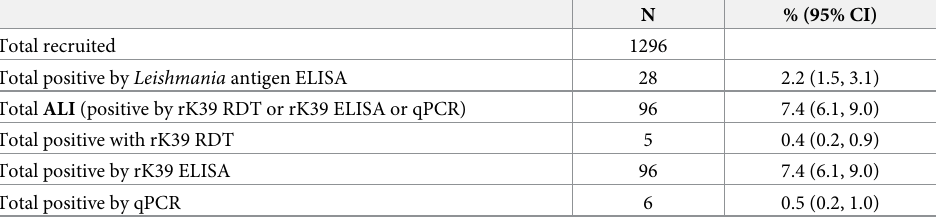
Table 6. Prevalence of asymptomatic Leishmania infection (ALI) in 1,296 people living with HIV (PLHIV) in Bihar, India by serological, molecular, and antigen detection methods.